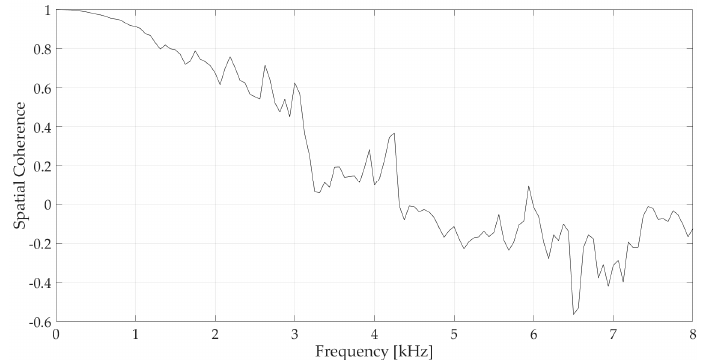
Figure 9. The spatial coherence of noise signals of microphone array.